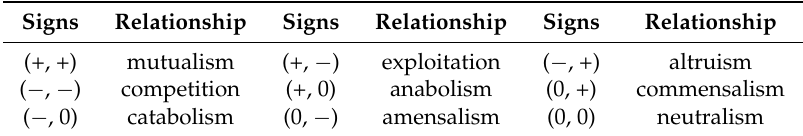
Table 1. The nine sign combinations for relationships of paired nodes in the network system. Signs Relationship Signs Relationship Signs Relationship (+, +) mutualism (+, ´ ) exploitation ( ´ , +) altruism ( ´ , ´ ) competition (+, 0) anabolism (0, +) commensalism ( ´ , 0) catabolism (0, ´ ) amensalism (0,